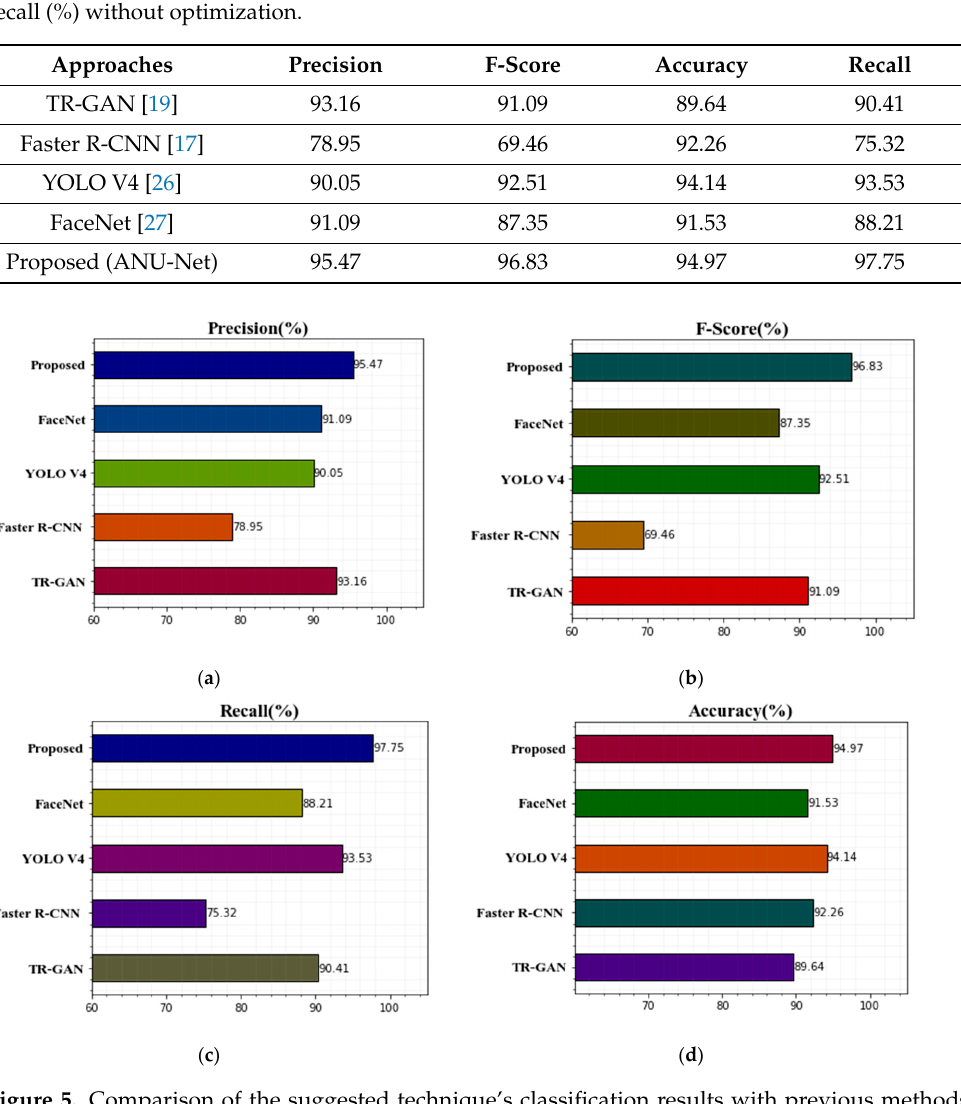
Figure 5. Comparison of the suggested technique’s classification results with previous methods without optimization algorithm ( a ) precision, ( b ) F-score, ( c ) recall, and ( d ) accuracy.